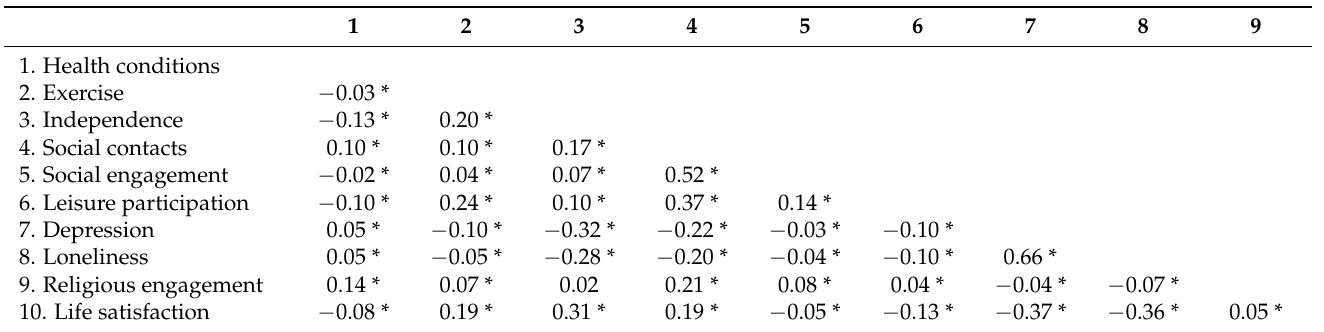
Table 1. Correlations among the